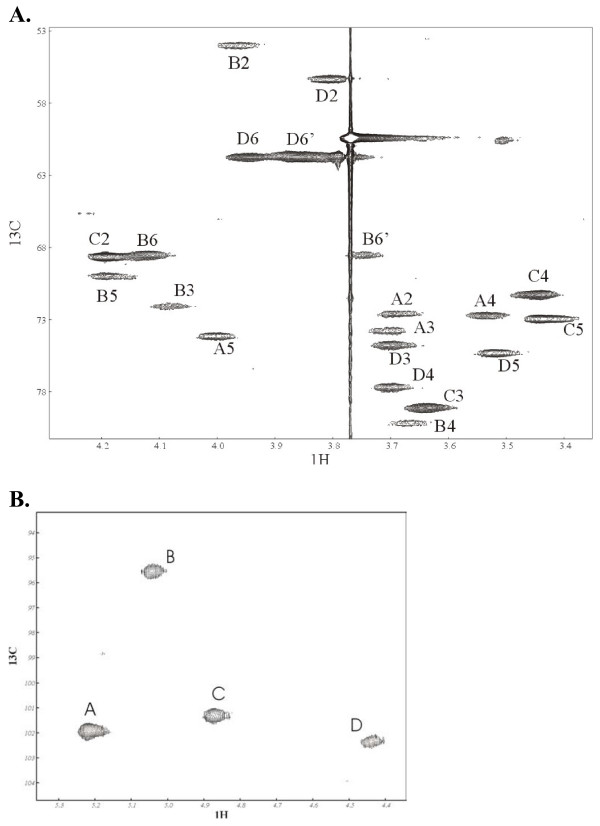
Panel A shows the HSQC spectrum of the de-O-acetylated capsular polysaccharide from NRT36S. The strong signal at 3.78, 60 ppm is a low molecular weight impurity. Panel B shows the signal from the anomeric region. The methyl group region is not shown.